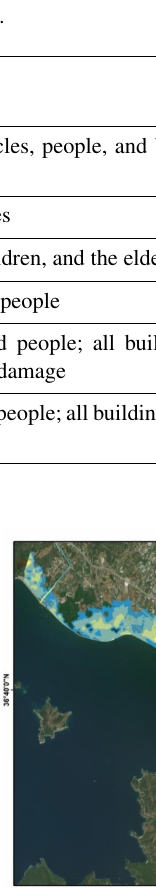
Table 3. Hazard classes and vulnerability thresholds (Smith et al., 2014).